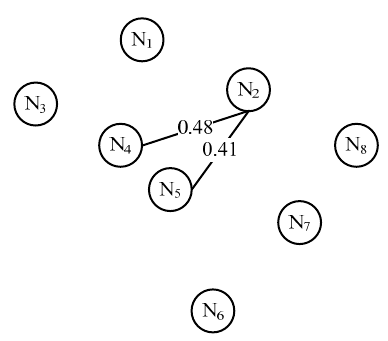
Figure 8. Segmentations of needs-related undirected graph.